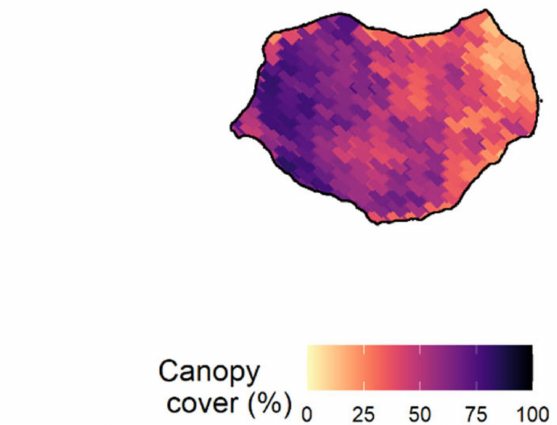
Figure A4. Maps of environmental variables across the main island of Puerto Rico. Top left: propor- tion of protected area (range: 0 to 100%); top right: proportion of canopy cover (range: 14 to 96%); bottom left: proportion of forest age between 34–54 years (range: 0 to 94%); bottom right: map of proportion of forest cover older than 54 years (range: 0 to 100%).